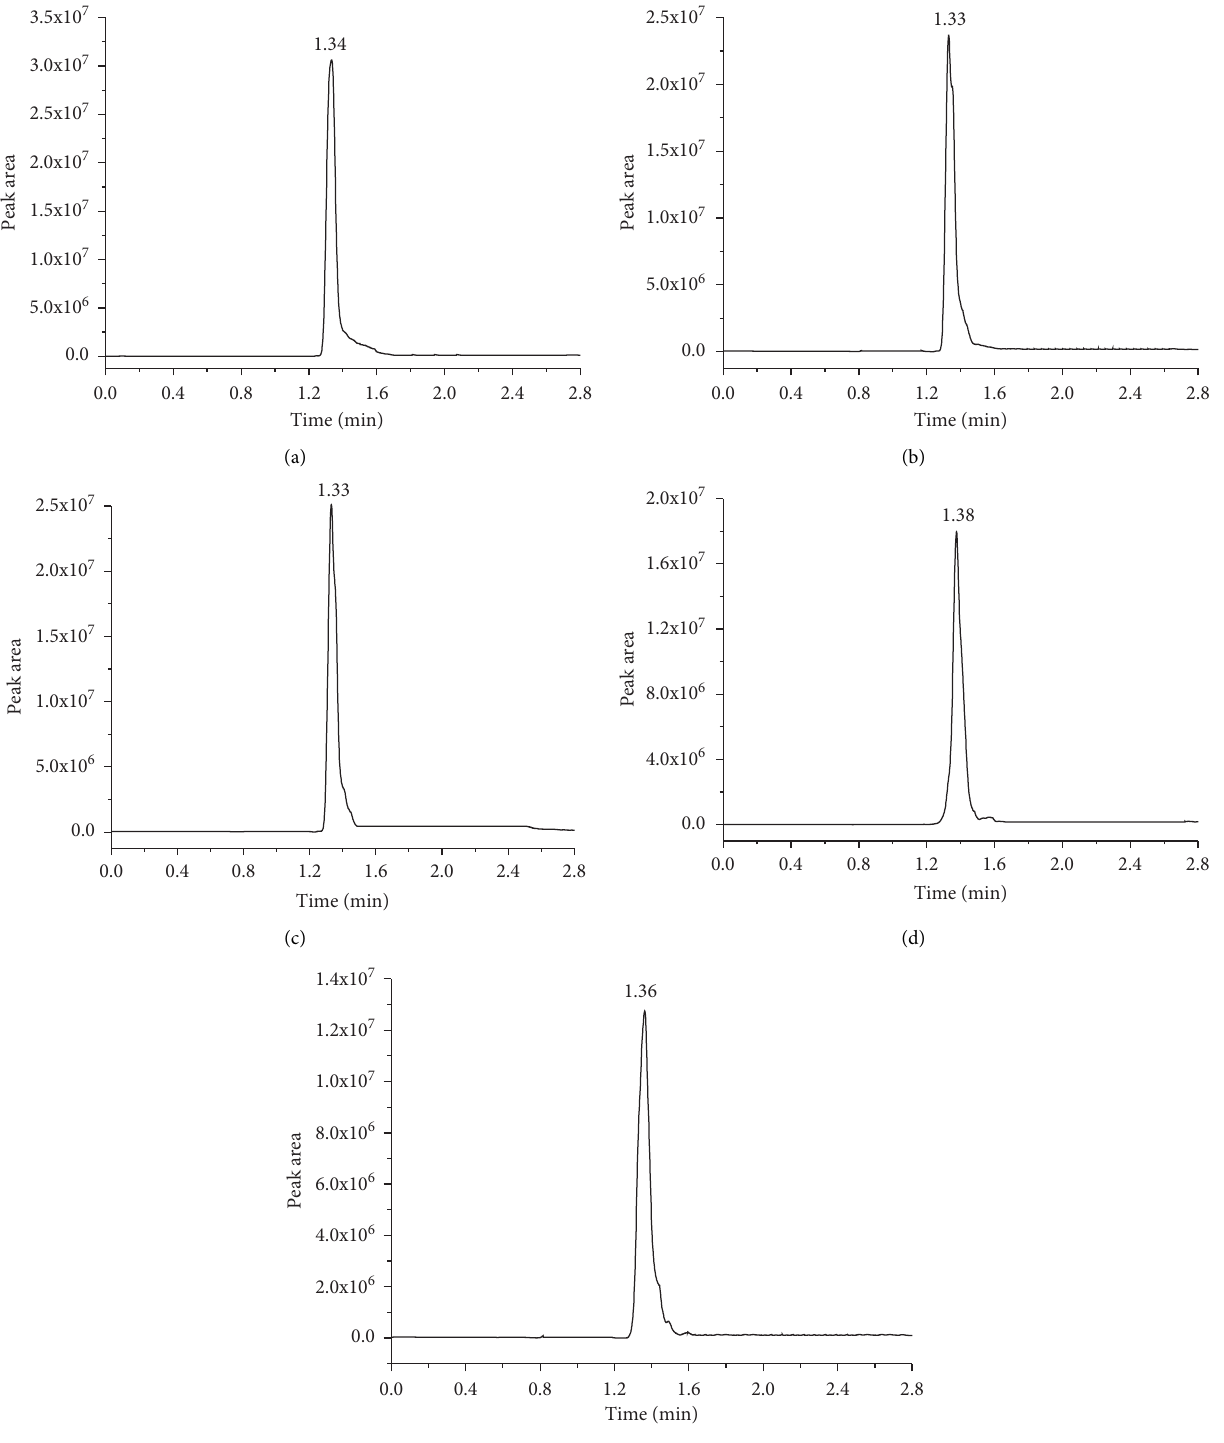
Figure 1: The UHPLC-MS/MS method was developed using the standard chromatograms of carrageenan in five types of livestock and poultry meat samples. The x -axis is the detection time (the value marked on the chromatographic peak represents the retention time of carrageenan); the y -axis is the peak area. Chromatogram of the carrageenan standard at 0.40g/kg in (a) pork (retention time 1.34min), (b) beef (retention time 1.33 min), (c) lamb (retention time 1.33min), (d) chicken (retention time 1.38min), and (e) duck (retention